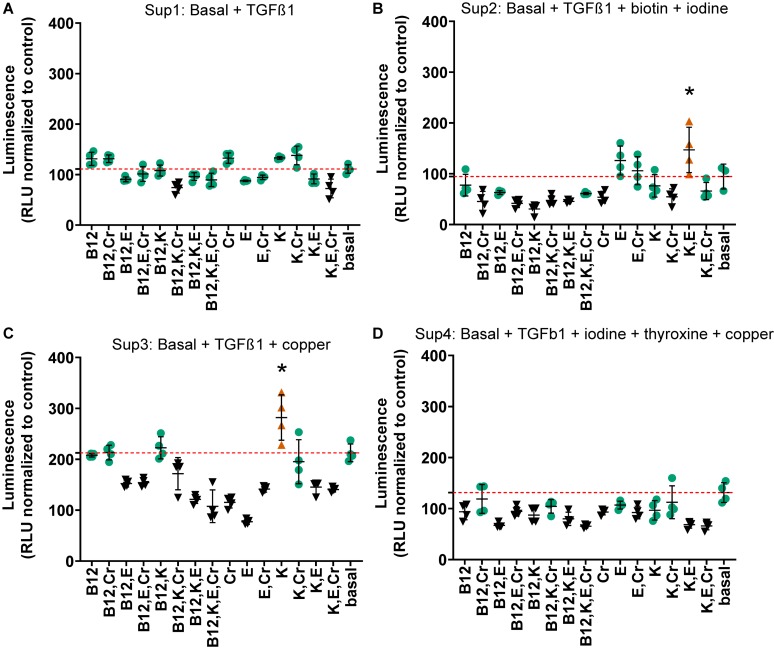
Combinations of chromium, vitamins B12, E, and K in supplemented media at day 21. Vitamins and minerals (chromium, vitamins B12, E, and K) which had been identified as promoting COL2A1 promoter-driven expression in the initial screen were tested alone and in combination in supplemented medias 1 (A) Basal media + TGFβ1; 2 (B) Basal + TGFβ1 + biotin + iodine; 3 (C) Basal + TGFβ1 + copper; 4 (D) Basal + TGFβ1 + iodine + thyroxine + copper. Vitamins and minerals were supplemented at their individually optimized concentration in basal media (2.8 μg/L, 91.4 ng/L, 1.84 μg/L, and 2.2 μg/L, respectively). The values are normalized to the plate control (basal media); the red dashed red line indicates the luminescence achieved with that particular supplemented media alone. Green circles indicate values that are not significantly different to supplemented media (red dashed line), all are greater than basal media. Conditions that were statistically greater than their respective supplemented media are represented by an orange triangle () and an *, black symbols (▼) indicate that those values were lower than the respective supplemented media. n ≥ 3 ± S.D.